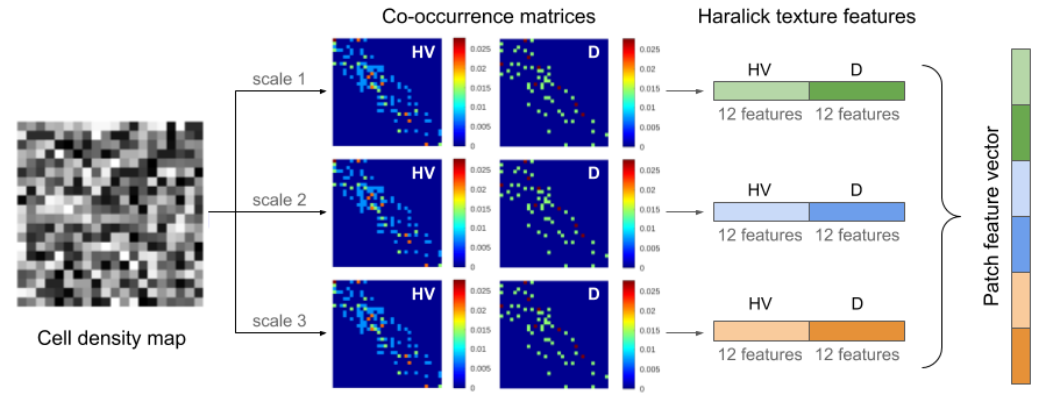
Figure 2. Multi-scale texture analysis of cellular density on digitized pathology to compute pathomic features: the cell density map of a particular histopathology patch is used to compute two co-occurrence matrices (one along the horizontal-vertical direction and one along the diagonal direction) per scale. These are then utilized to compute 12 Haralick texture features per co-occurrence matrix, from which statistics are computed to result in 360 pathomic